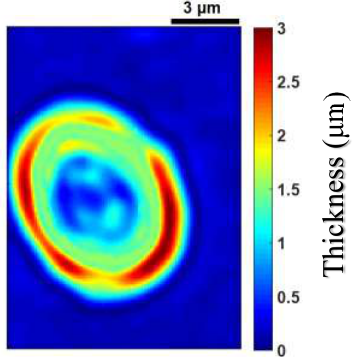
Figure 4. Topography of cell A .